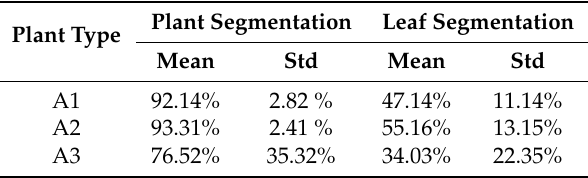
Table 4. Overall plant and leaf segmention results using the method of mean-shift clustering as described in Section